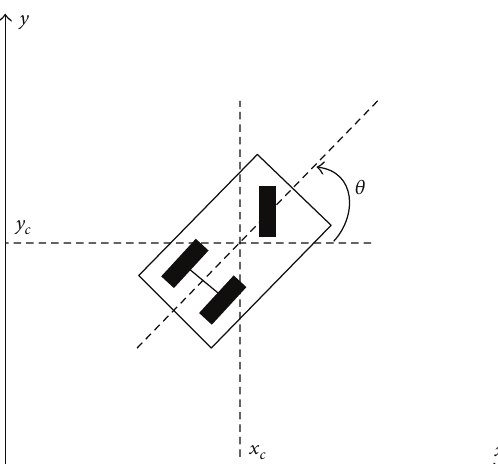
Figure 1: Schematic of the mobile